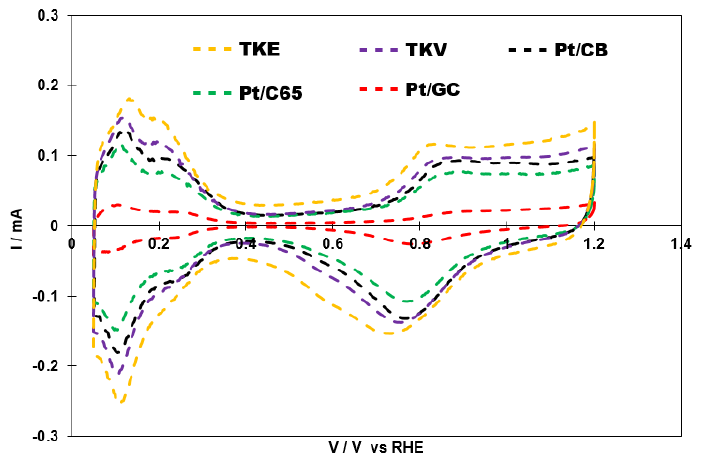
Figure 3. Cyclic voltammograms (CVs) of the supported catalysts at 50 mV s −1 in 0.1 M HClO 4 at RT, 2 µg Pt on rotating disk electrode (RDE).